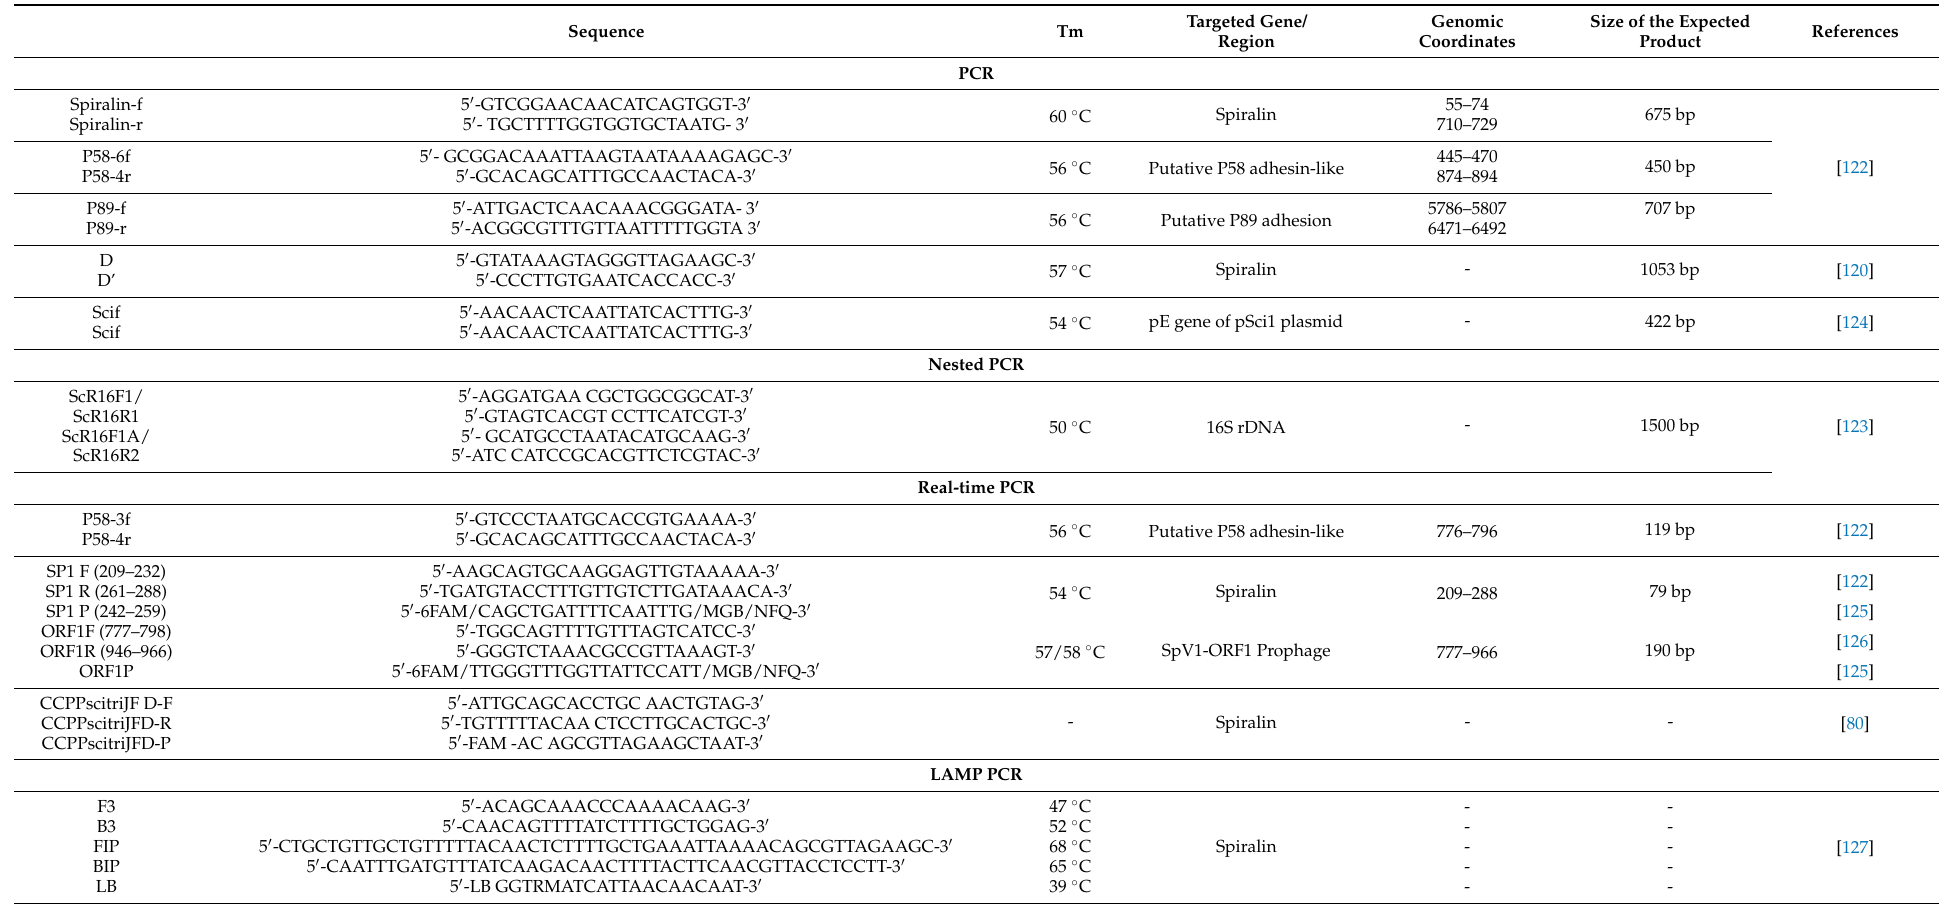
Table 3. Primer sequences and their annealing temperature (Tm), primer/probe location, and expected size of PCR products for each primer pair when used to amplify Spiroplasma citri by PCR and related